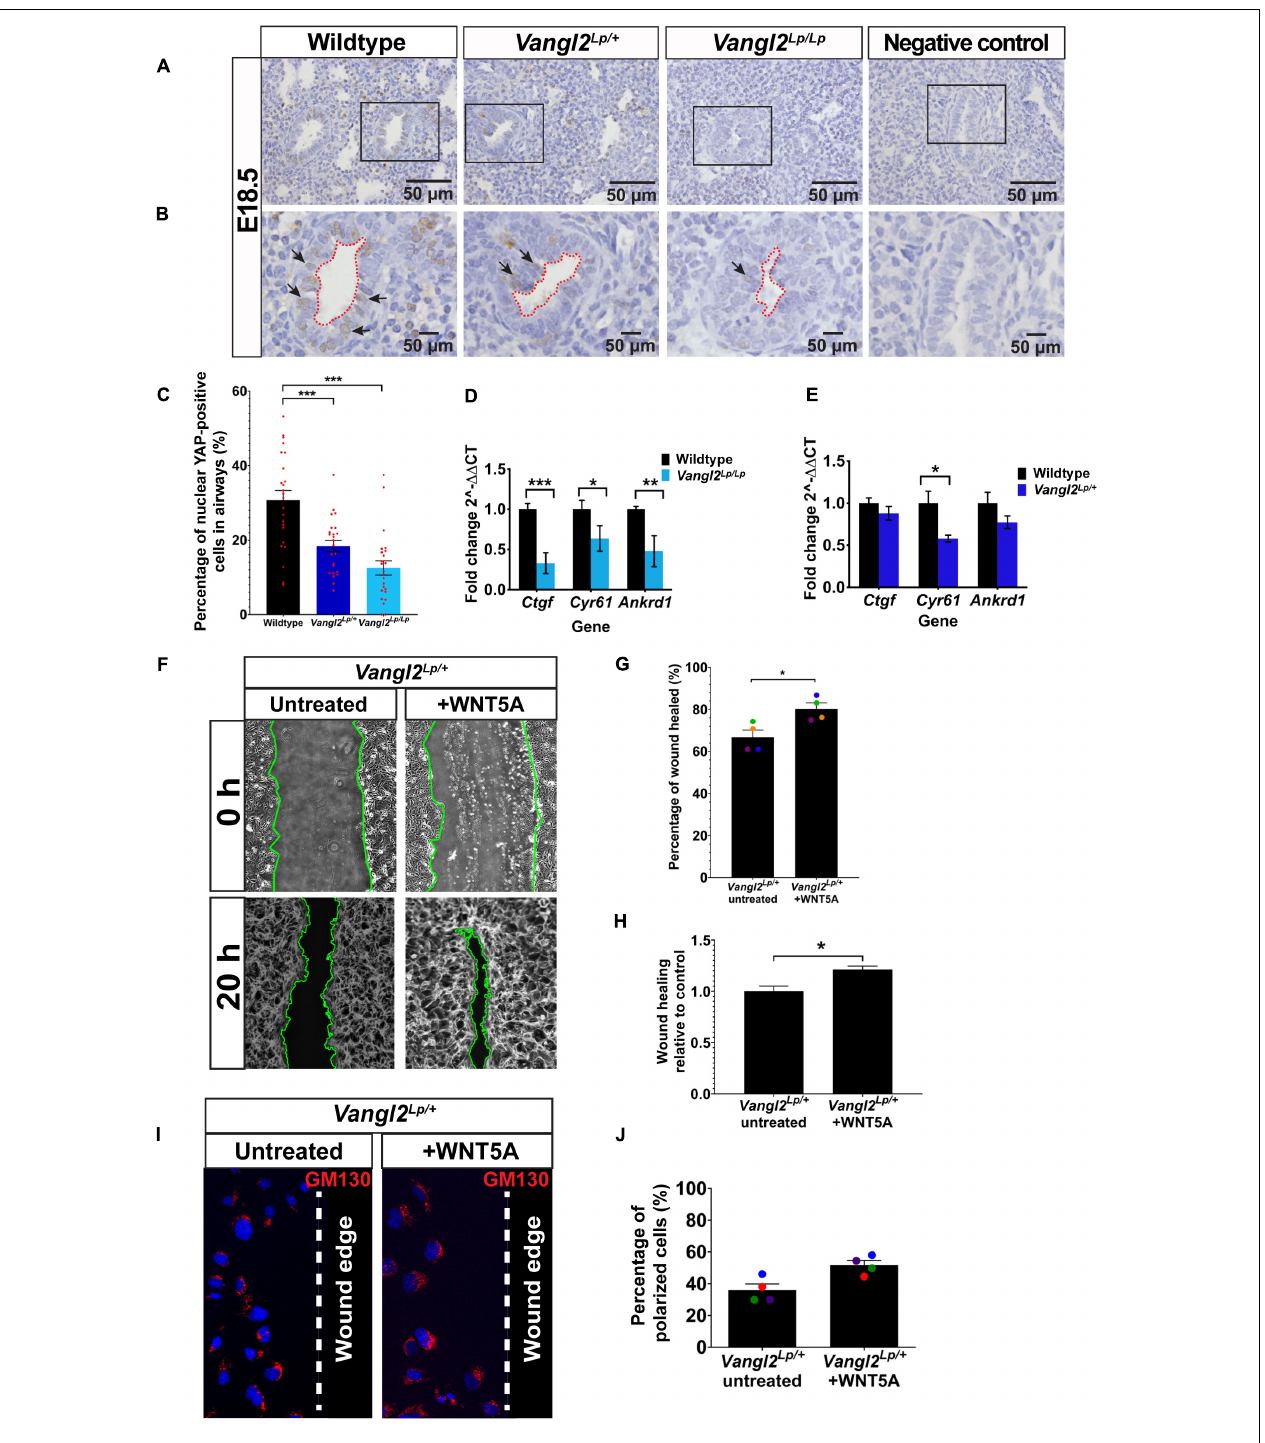
FIGURE 6 | Reduced YAP signaling in embryonic Vangl2 Lp airways and WNT5A rescues cell migration defects in Vangl2 Lp / + . (A,B) Representative images show immunostaining for YAP in E18.5 wildtype, heterozygous Vangl2 Lp / + , and homozygous Vangl2 Lp / Lp mouse lungs. Sections were counterstained with hematoxylin. Negative controls with primary antibody omitted are shown. Insets (B) show the morphology of airway lumen. Arrows indicate nuclear YAP staining. (C) Percentage of nuclear YAP-positive cells in the airways. n = 3 mice per group; eight airways were quantified per mouse; a total of 1389 cells (wildtype), 1381 cells ( Vangl2 Lp / + ), and 995 cells ( Vangl2 Lp / Lp ) were analyzed (presented as mean ± SEM); one-way ANOVA with Tukey’s post hoc test, *** p < 0.001. Histograms show transcript levels for YAP target genes: Ctgf , Cyr61 , and Ankrd1 in E18.5 wildtype vs Vangl2 Lp / Lp (D) and adult wildtype vs Vangl2 Lp / + lungs (E) . n = 3 independent